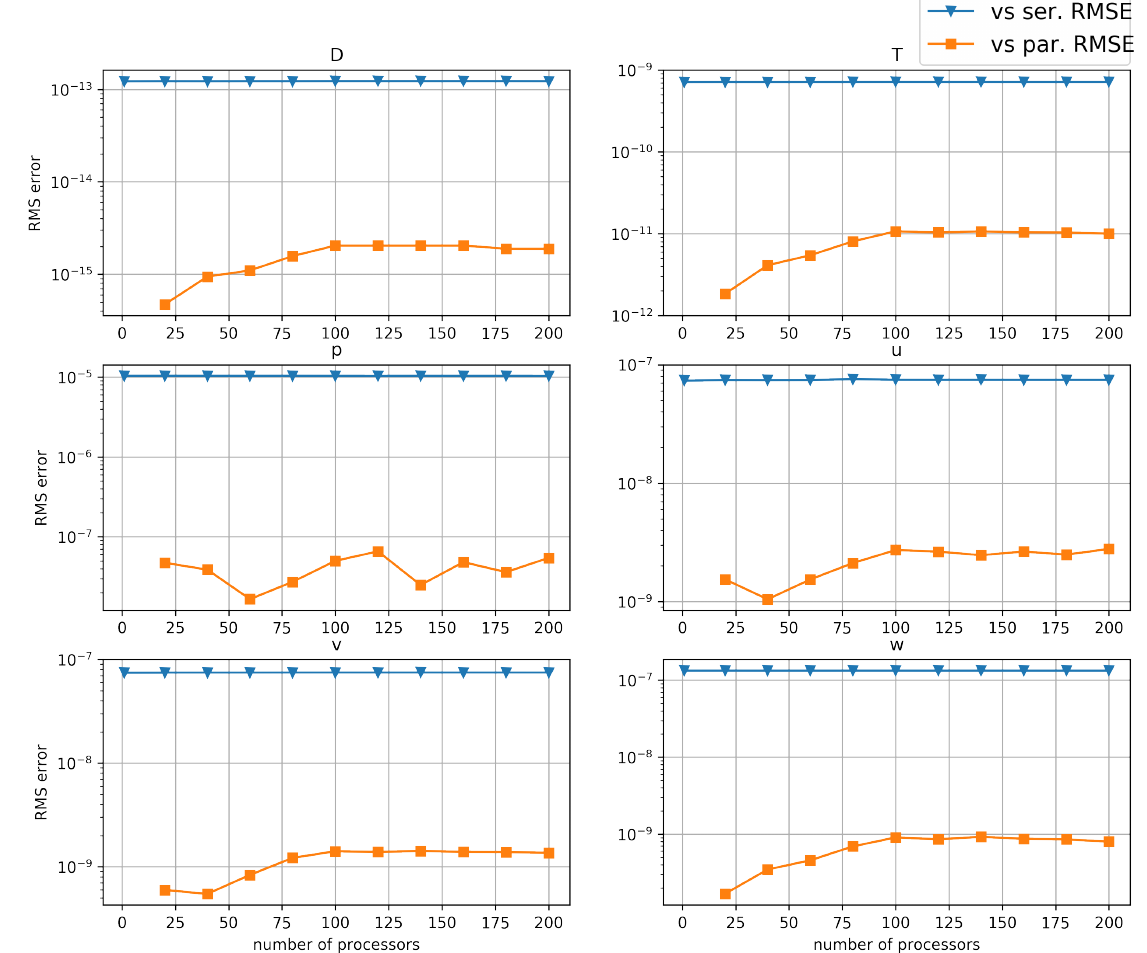
Figure 4. Error comparison between serial and parallel models for one processor output, the parallel error is consistently orders of magnitude smaller than the serial comparison, which in turn is small enough to carry the physics validation of the model. Comparison with Serial GCCOM